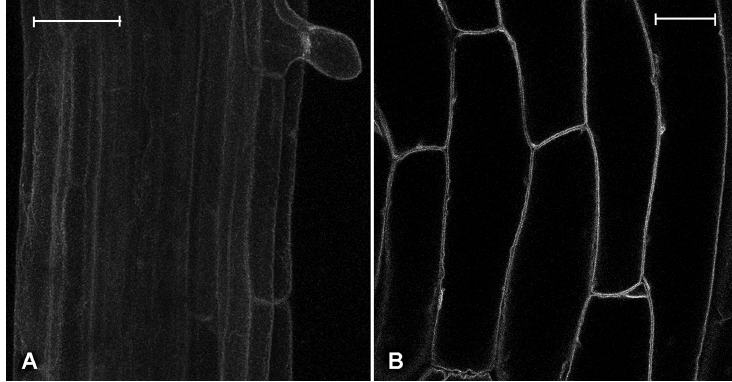
Figure 3. Fluorescent patterns of GFP-tagged tonoplast intrinsic protein 1-1 (TIP1.1-GFP) tonoplast marker, in different tissues. ( A ) Confocal sections projection of the young root at the level of trichoblast differentiation in control conditions; ( B ) Single confocal section of hypocotyl’s cells in control conditions. Scale bar: 20 µm.